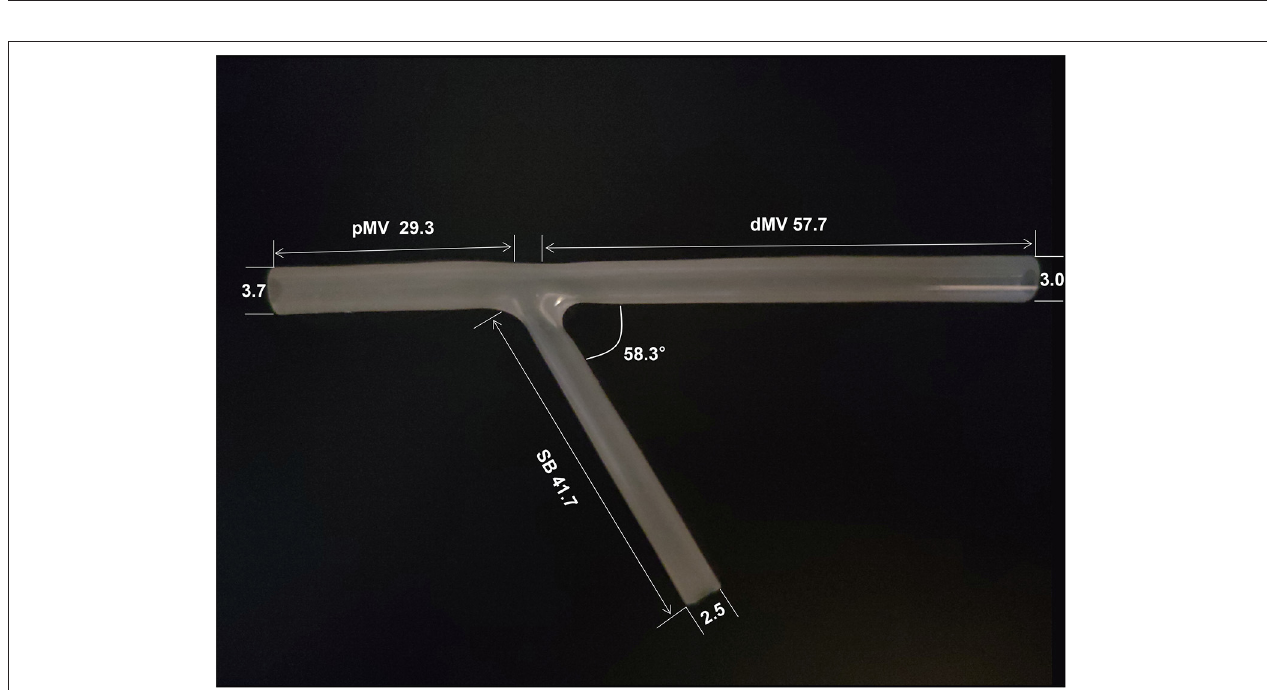
FIGURE 2 | Bench test model of bifurcation stenting. The length of the pMV, dMV and SB is 29.3, 57.7 and 41.7mm respectively. The inner lumen diameter of the pMV, dMV and SB is 3.7, 3.0 and 2.5mm respectively. The bifurcation angle is 58.3 ◦ . pMW, proximal main vessel; dMV, distal main vessel; SB, side branch.